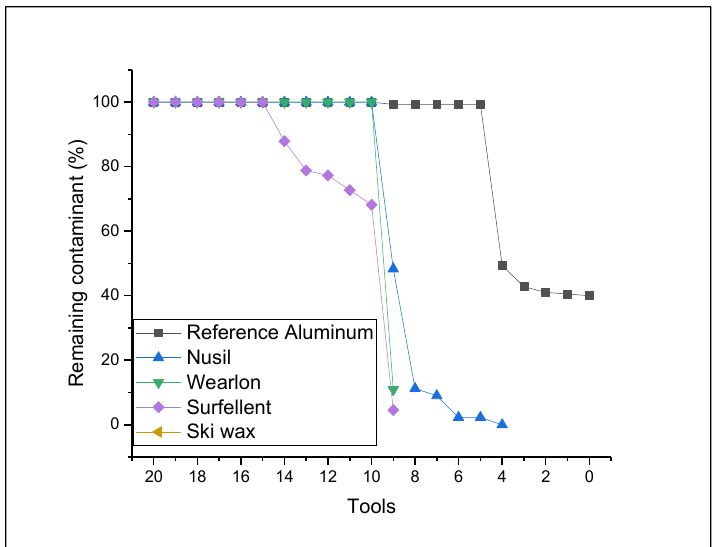
Figure 9. Multi-tool analysis under low-intensity freezing rain. Note: Numbers correspond to the tool used and the number of passages during de-icing. Where “20 to 16” represent the Broom, “15 to 11” represent the soft polymer blade, “10 to 6” represent the squeegee, “5 to 1” represent the hard polymer blade, and 0 indicates that ice remained on the surface.